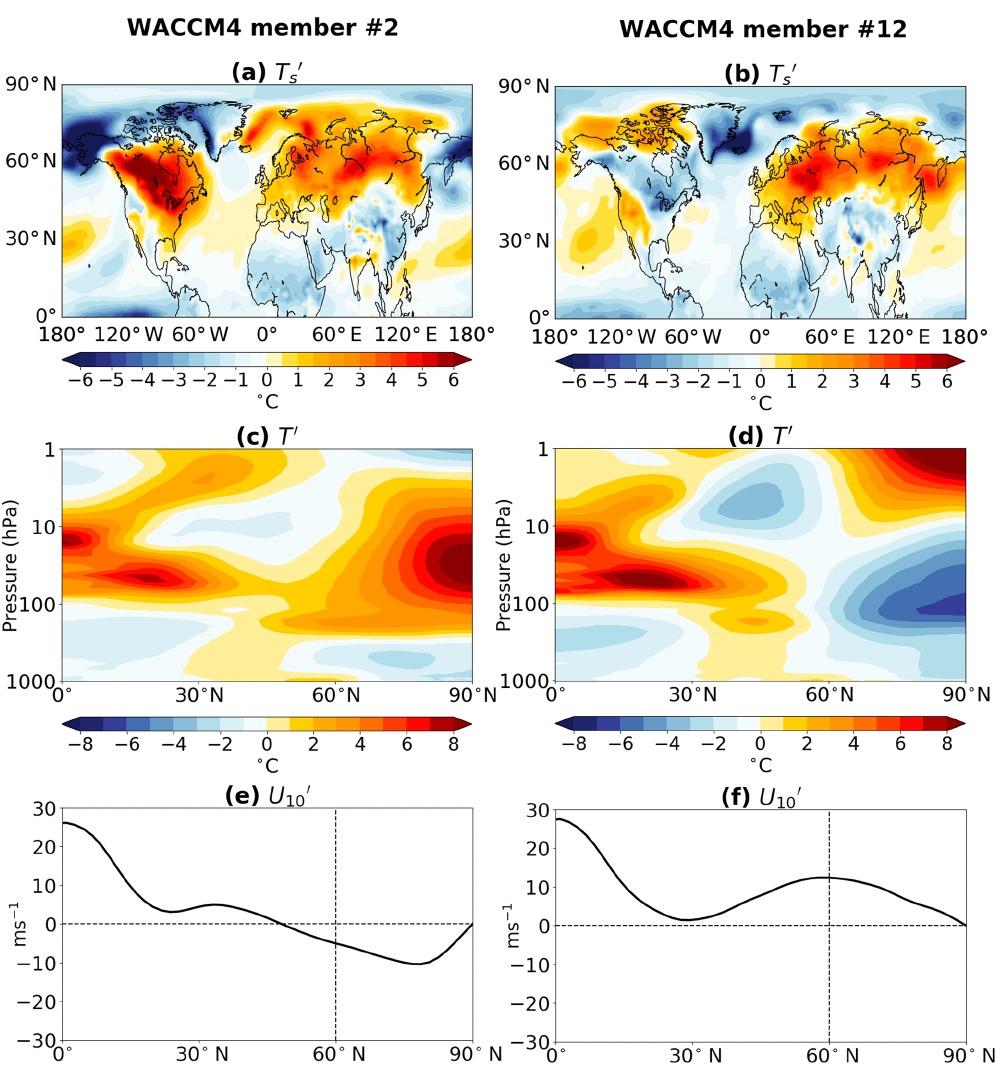
Figure 6. The surface temperature T (cid:48) s (a, b) , the zonal mean temperature T (cid:48) (c, d) and 10hhPa zonal mean zonal wind U (cid:48) WACCM4 member no. 2 (a, c, e) and member no. 12 (b, d, f)